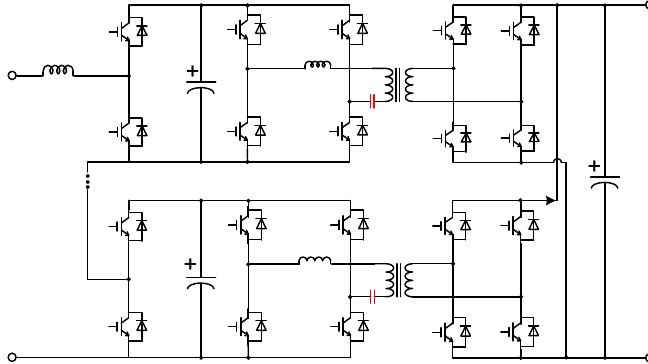
Figure 10. DCT for the pure PV accesses scenario.